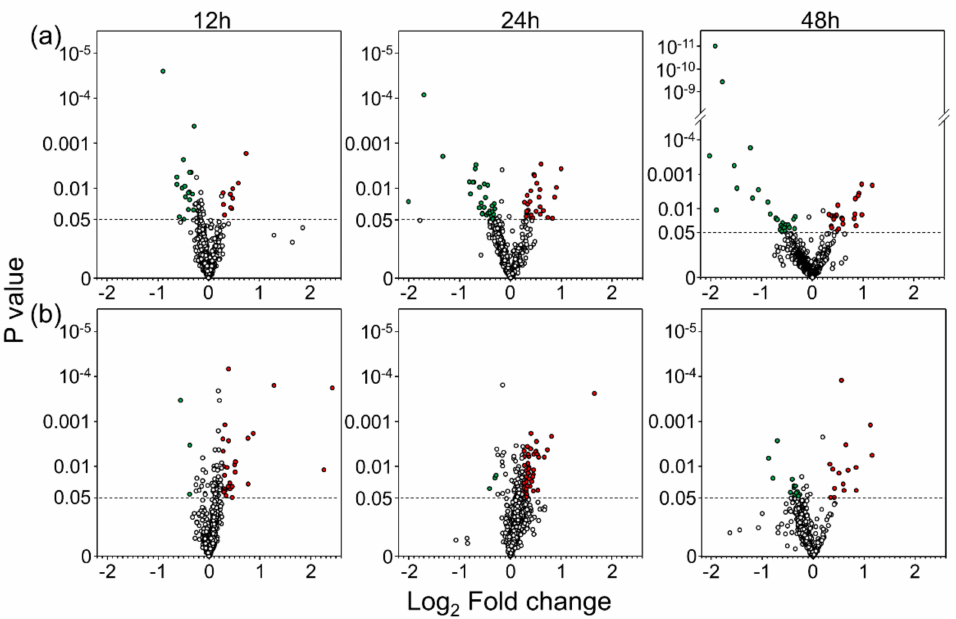
Figure 2. Volcano plots of ( a ) BafA1- and ( b ) Rapa-treated U-251 proteins after indicated times of treatment. Each protein measured by SOMAscan ® is represented by a circle. The dashed horizontal lines indicate p -value of 0.05 with circles above the lines being significantly dysregulated. Fold change cut-o ff s of + 1.33 and -1.33 ( ± 0.415 Log 2 ) are indicated with red and green filled circles, respectively. Values represent averages of three